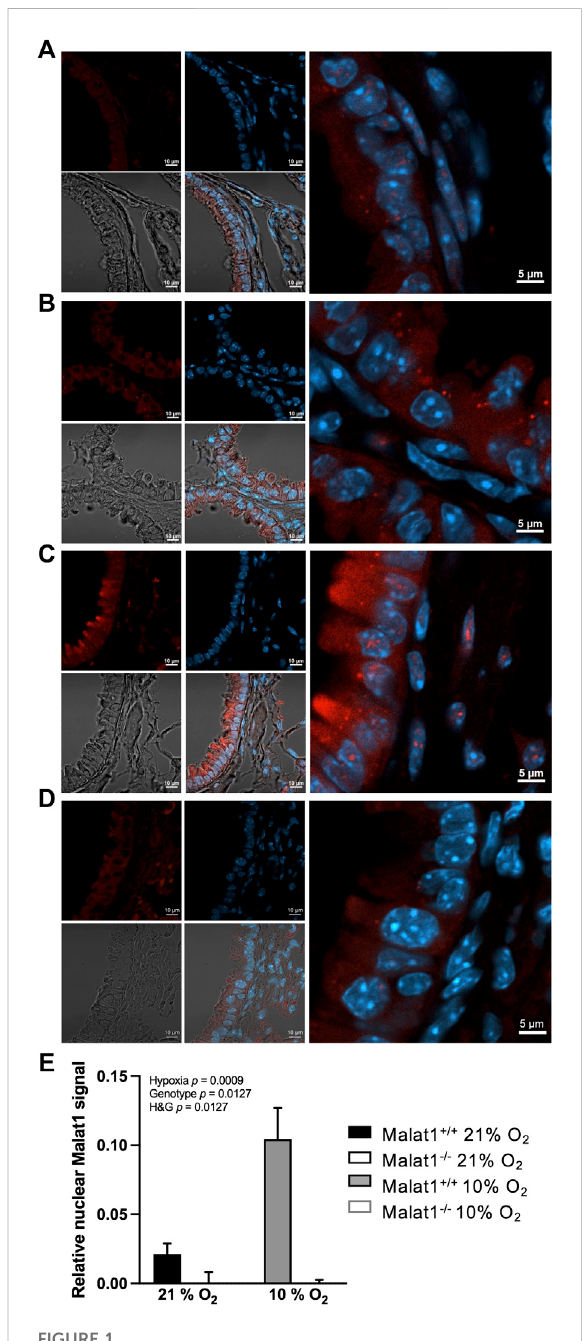
FIGURE 1 Malat1 expression. Representative confocal images of RNA FISH performed on lung sections from Malat1 +/+ mice housed at 21% O 2 (A) , Malat1 − / − mice housed at 21% O 2 (B) , Malat1 +/+ mice housed at 10% O 2 (C) , and Malat1 − / − mice housed at 10% O 2 (D) .Tissuesectionsderivedfromfourindependentmicepergroup were examined and one representative image per group is shown. Malat1 appears in red and Hoescht-stained nuclei appear blue. 3 – 5 lung slices per animal were analyzed and used for quanti fi cation (E)